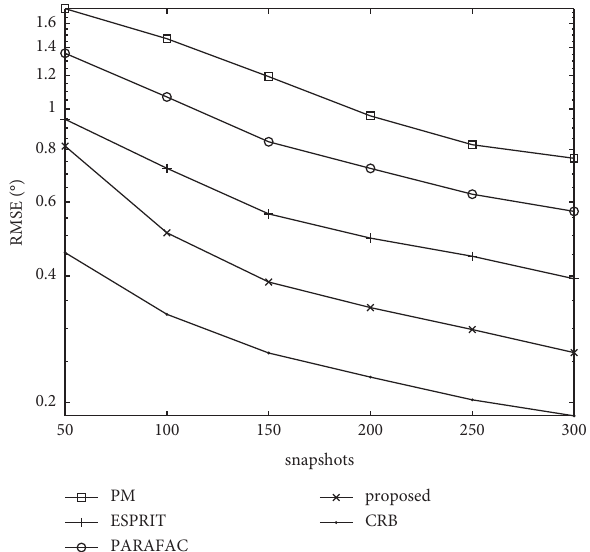
Figure 10: c estimation of different algorithms versus snapshot.